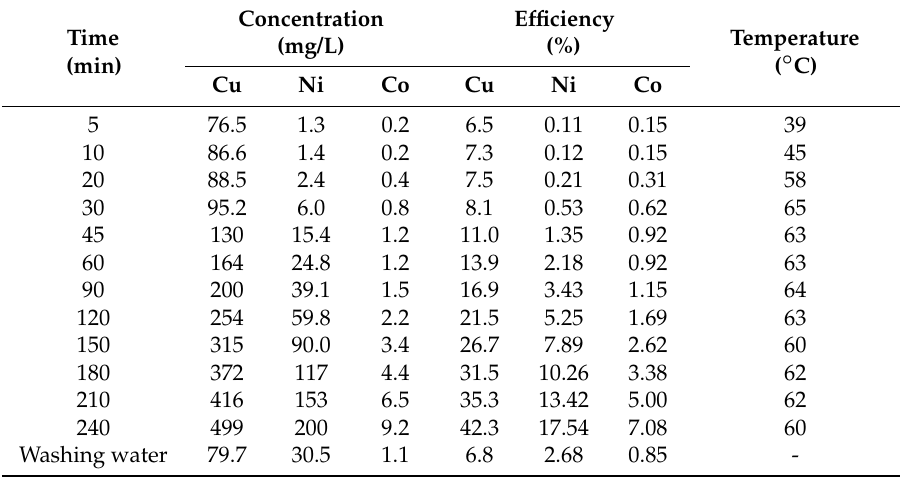
Table 8. Metals concentration and extraction efficiency of ammoniacal leaching with microwave (30 W). Concentration Efficiency Time (mg/L) (min)